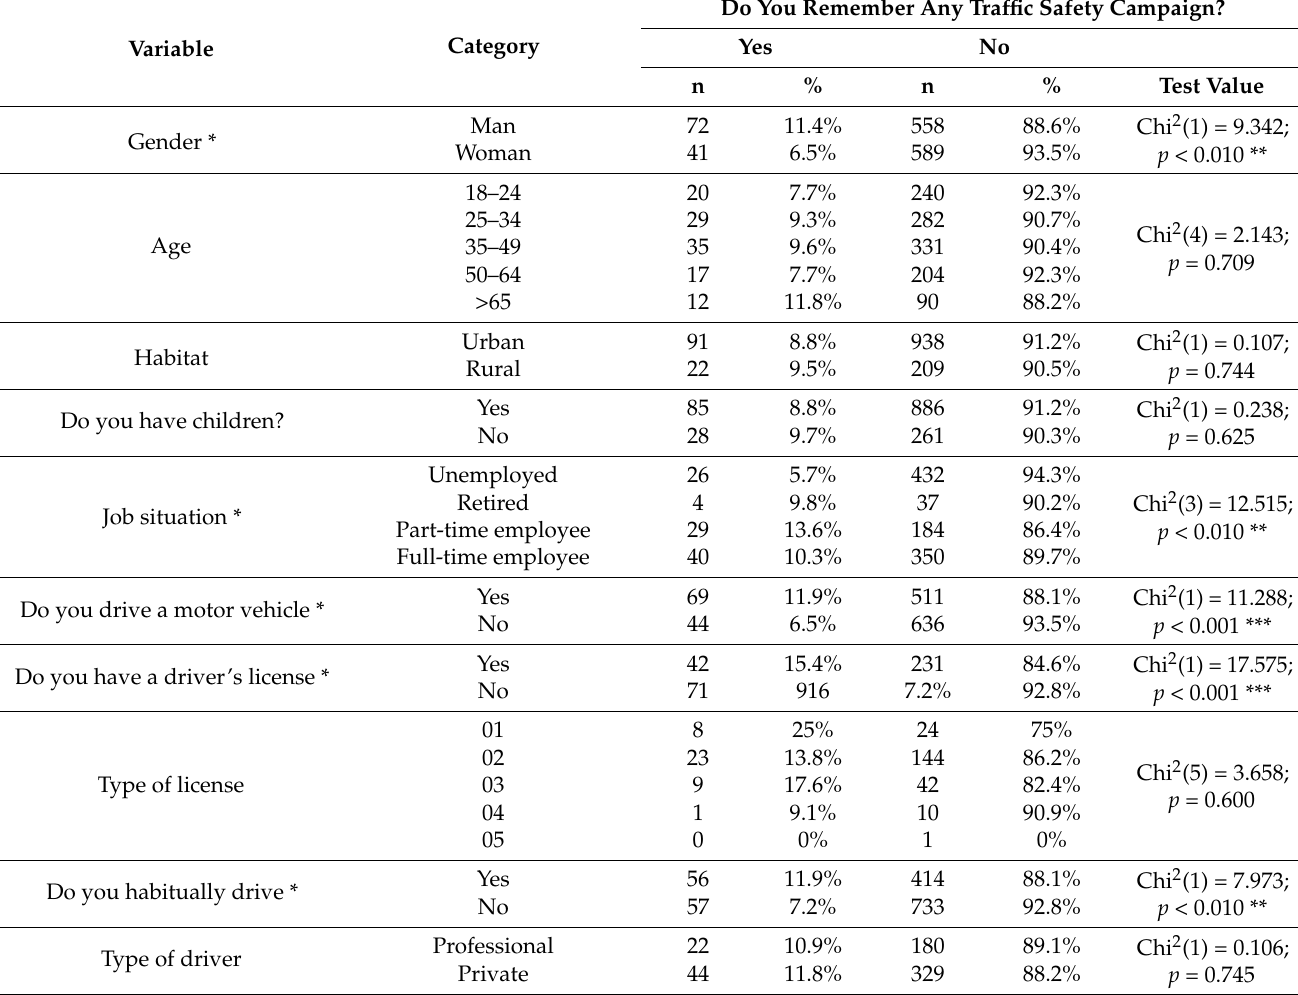
Table 3. Memories of traffic campaigns depending on sociodemographic